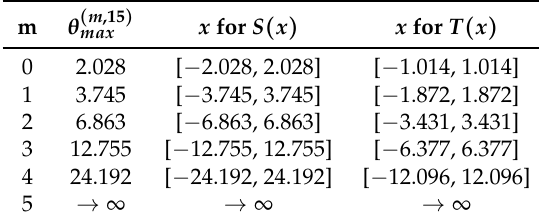
Table 2. An Extension of the Input Ranges.